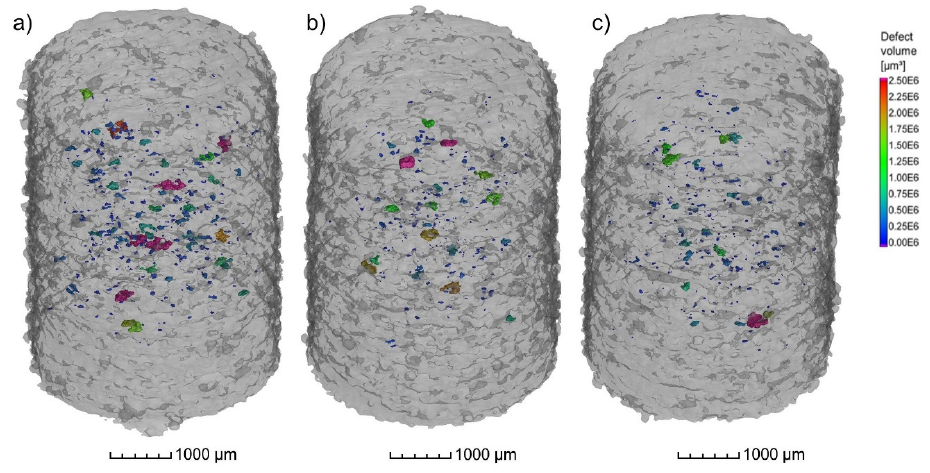
Figure 13. µCT Images of the cylindrical samples (Ø4 × 6 mm 3 ) built with the different X2CrNi- X2CrNiMoCuWN25-7-4 powders (particle size 20–63 µ m, voxel size 7.99 µ m) atomized with MoCuWN25-7-4 powders (particle size 20–63 µm, voxel size 7.99 µm) atomized with ( a ) N 2 /N 2 at ( a ) N 2 /N 2 at RT; ( b ) N 2 /N 2 at 330 ◦ C; and ( c ) Ar/Ar at 330 ◦ C. The laser power was 250 W, and the RT; ( b ) N 2 /N 2 at 330 °C; and ( c ) Ar/Ar at 330 °C. The laser power was 250 W, and the laser scan speed was 800 mm/s. The building direction is upward. laser scan speed was 800 mm/s. The building direction is